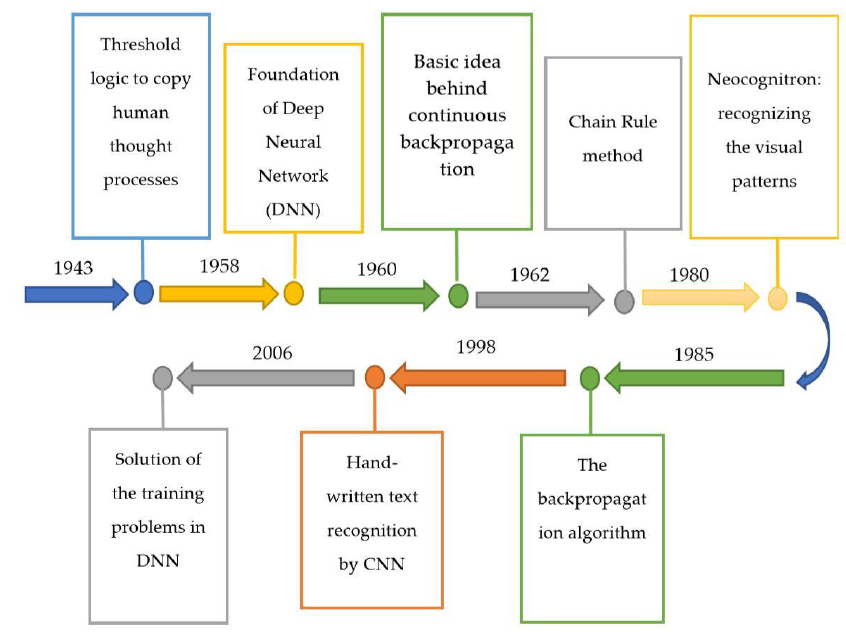
Figure 1. Summary of the evolution of deep learning from 1943–2006.